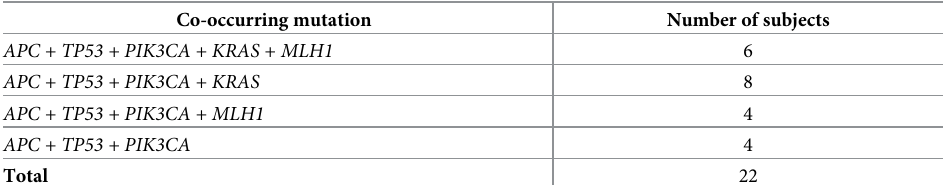
Table 3. Subjects with co-occurring mutation.